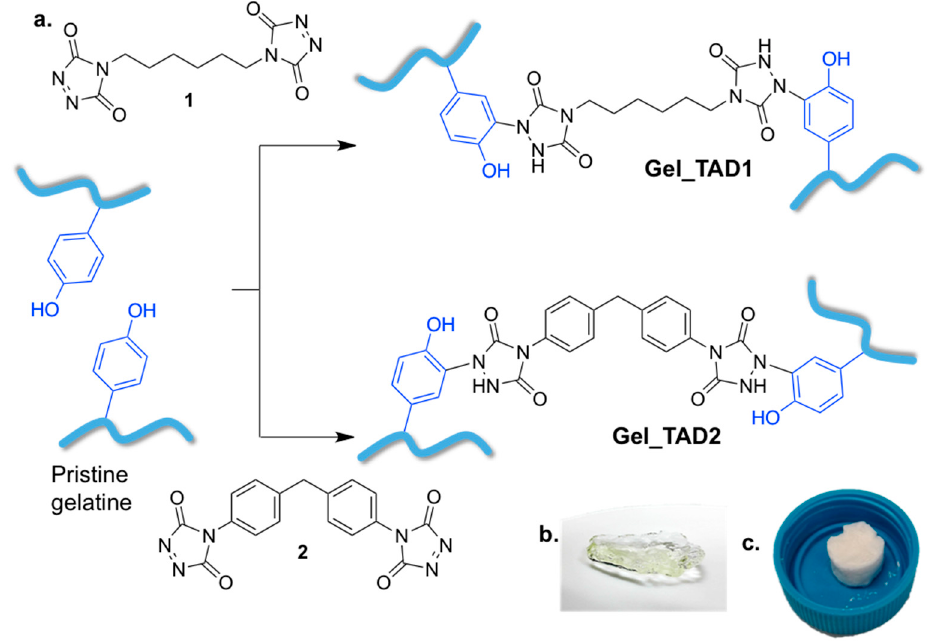
Figure 2. ( a ) cross-linking reaction between gelatin and 1 or 2 ; ( b ) recovered hydrogels; ( c ) dried cross-linked gelatin hydrogels.